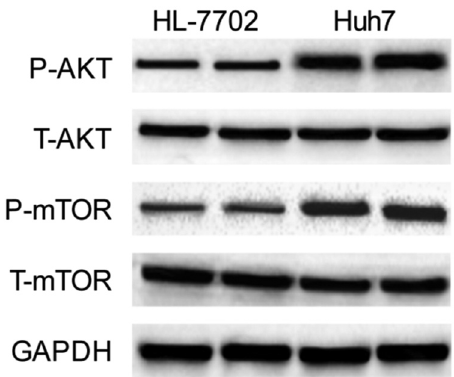
Figure A3: The activation of PI3K/AKT signaling pathway in HL - 7702 and Huh7 cells. Immunoblot showed AKT and mTOR phosphoryla - tion and total levels in HL - 7702 and Huh7 group. n = 3 independent experiments. * p < 0.05 compared with control